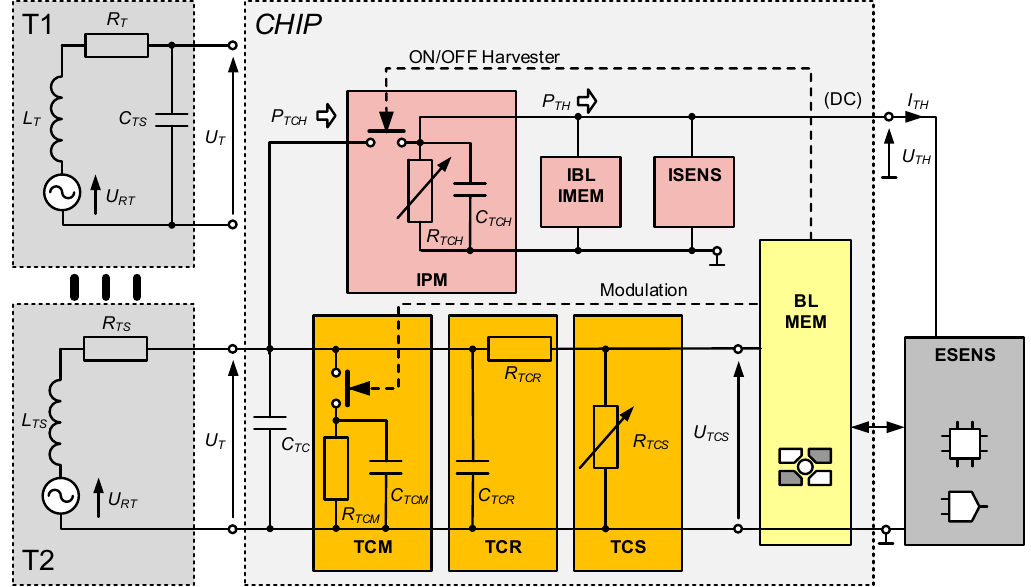
Figure 13. Block diagram of the modified model of semi-passive RFID transponder-sensor (block designation according to Figure 3). T1—parallel model of antenna; T2—corresponding serial model of antenna at given frequency; L T —self-inductance of antenna loop; R T —resistance of tracks and heat losses in antenna loop; C TS —resultant of all inter-turn capacities in antenna; R TS and L TS —resistance and inductance in serial antenna circuit antenna at given frequency; U TH and I TH —constant voltage and current at output of energy harvester; U RT —voltage induced in antenna loop; P TCH / P TH —input / output power of energy harvester; R TCR , R TCS , R TCM —resistance of respectively: voltage rectifier, voltage regulator and modulator; C TCM —capacity of modulator; C TC —input capacity of RFID chip.